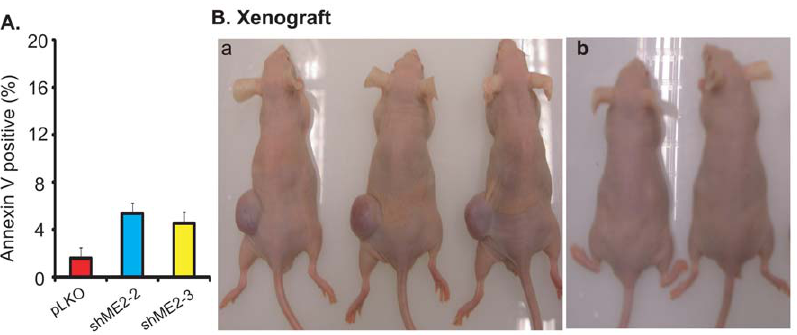
Figure 3. Stable knockdown of endogenous ME2 levels in K562 cells results in apoptosis invitro and suppresses tumor formation from K562 cells invivo . A: Knockdown of ME2 induces apoptosis in K562 as detected using the annexin V reagent. Data are expressed as mean 6 SD, n=3. B: Stable knockdown of ME2 in K562 cells failed to generate tumors in nude mice. Approximately 10 7 ME2 deficient or control K562 cells resuspended in 200 m l of a serum-free culture medium/Matrigel mixture (1:1) were subcutaneously implanted into female athymic nude mice as described under ‘‘Materials and Methods’’. Tumor-bearing mice were sacrificed after 4 weeks and the mice photographed before excision and weighing. a, Left (L): pLKO; Right (R): shME2-2: b, L and R: shME2-3. Tumors formed only in the pLKO transduced